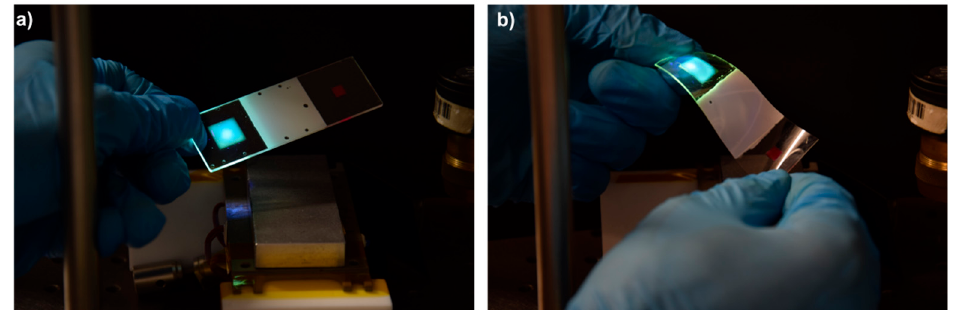
Figure 5. ( a ) Optical planar waveguide sensor including a luminescent coupling element and a luminescent temperature readout element fabricated on ( a ) a rigid cyclic olefin polymer (COP) substrate and ( b ) a flexible COP thin sheet. The sensor, at RT, is in the low T/high scattering state, and the luminescent coupling element is excited with a UV LED placed on